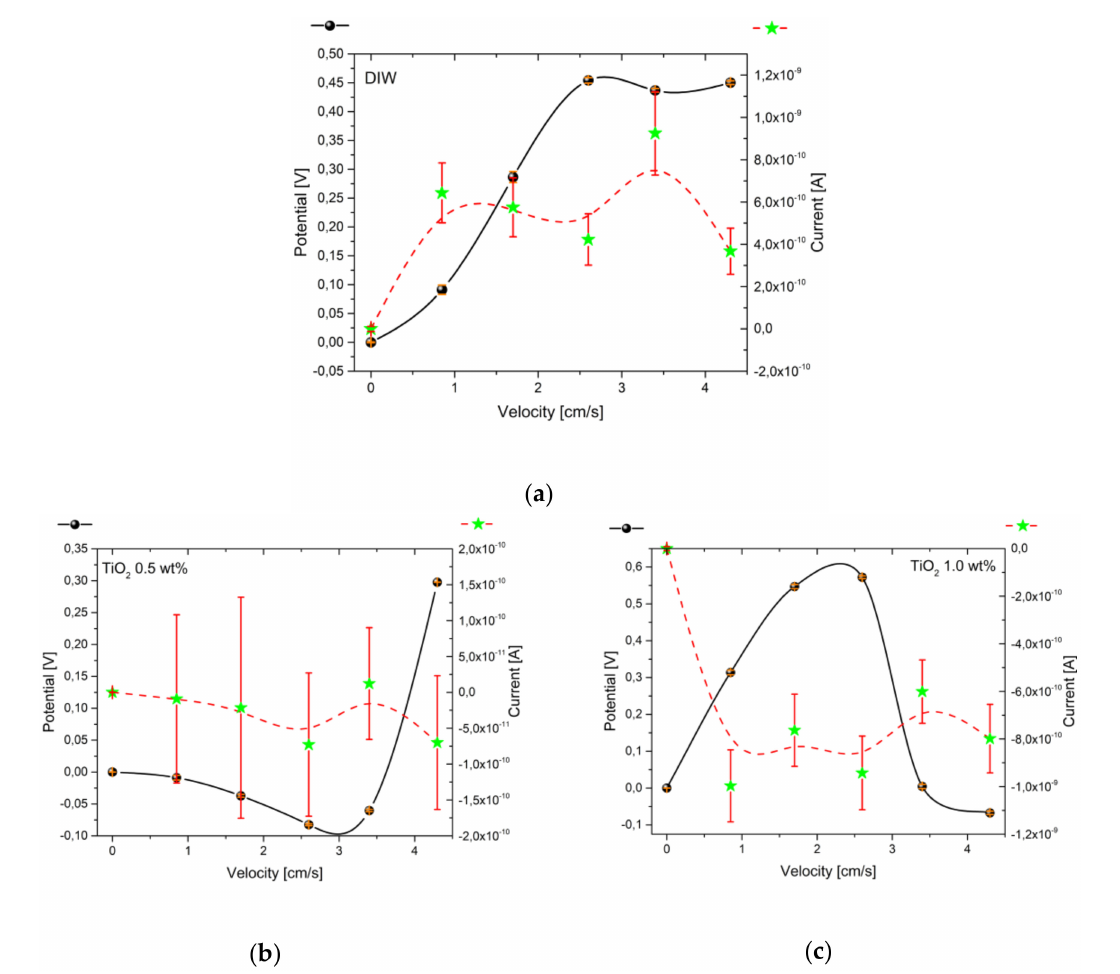
Figure 6. Open-circuit voltage and short-circuit current characterization in function of the mean velocity of DIW ( a ), 0.5% ( b ) and 1% ( c ) TiO 2 -water